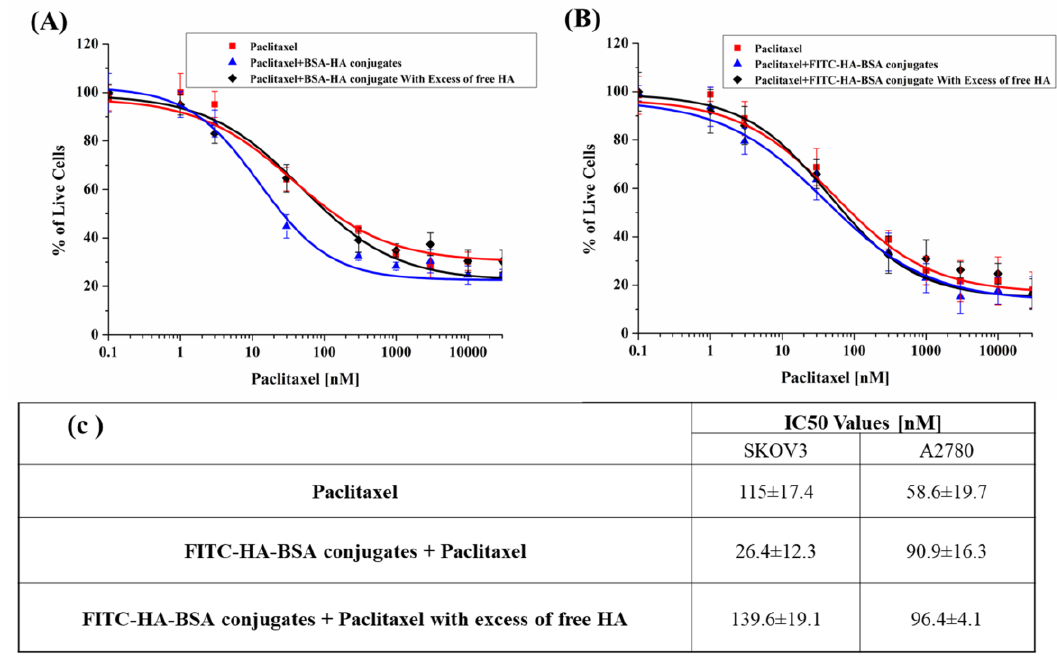
Figure 8. Survival of ( A ) SKOV3 and A2780 ( B ) cells incubated with PTX ( ■ ) vs. PTX encapsulated within FITC-HA-BSA conjugate NPs ( ▲ ) or with excess free HA (100-fold higher concentration of free HA compared to the conjugated HA) ( ◊ ). C. Summary of the IC 50